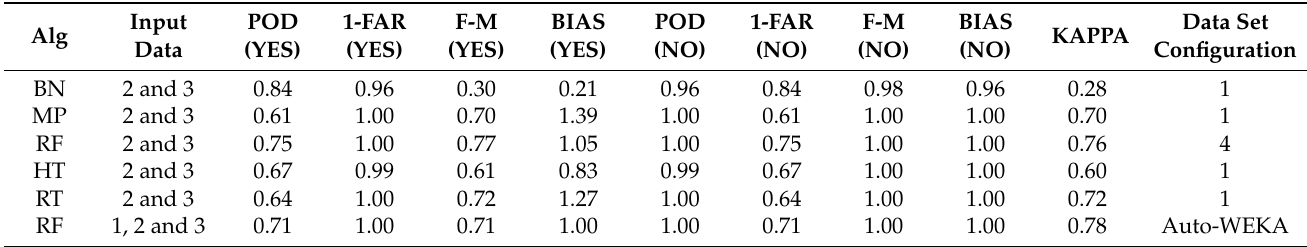
Table 7. Statistical test results of 30 min Vis forecasts ≤ 3700 m for the five algorithms (Alg) selected with input from SODAR (source 1), ASWS (source 2) and observer (source 3).